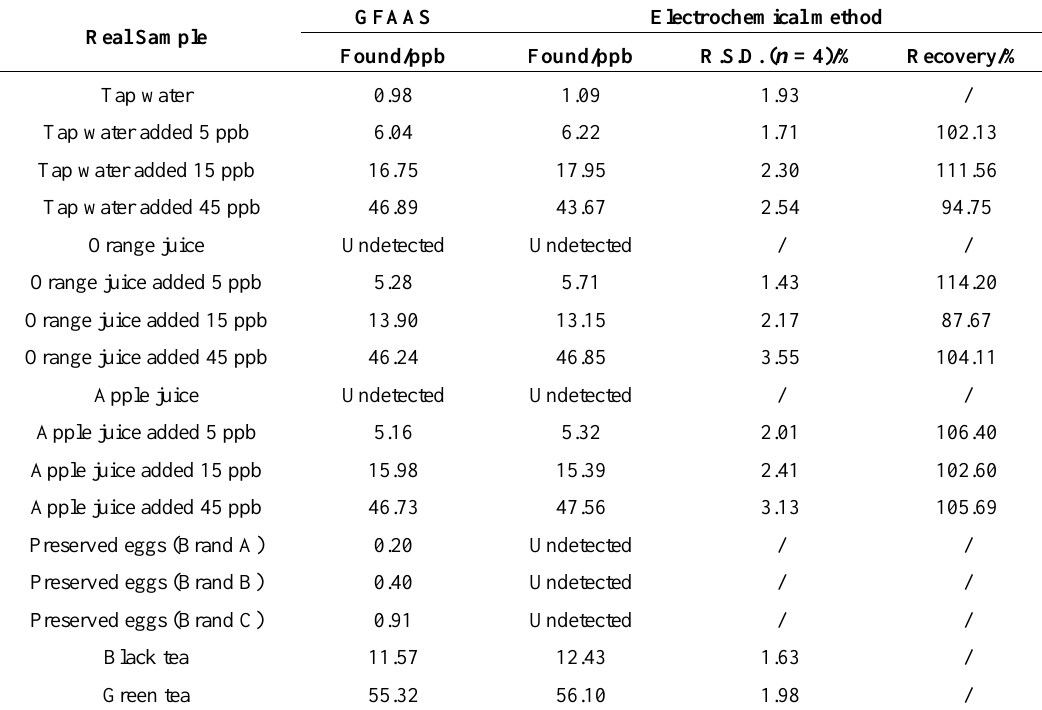
Table 3. Comparison of the results of electrochemical analysis method and